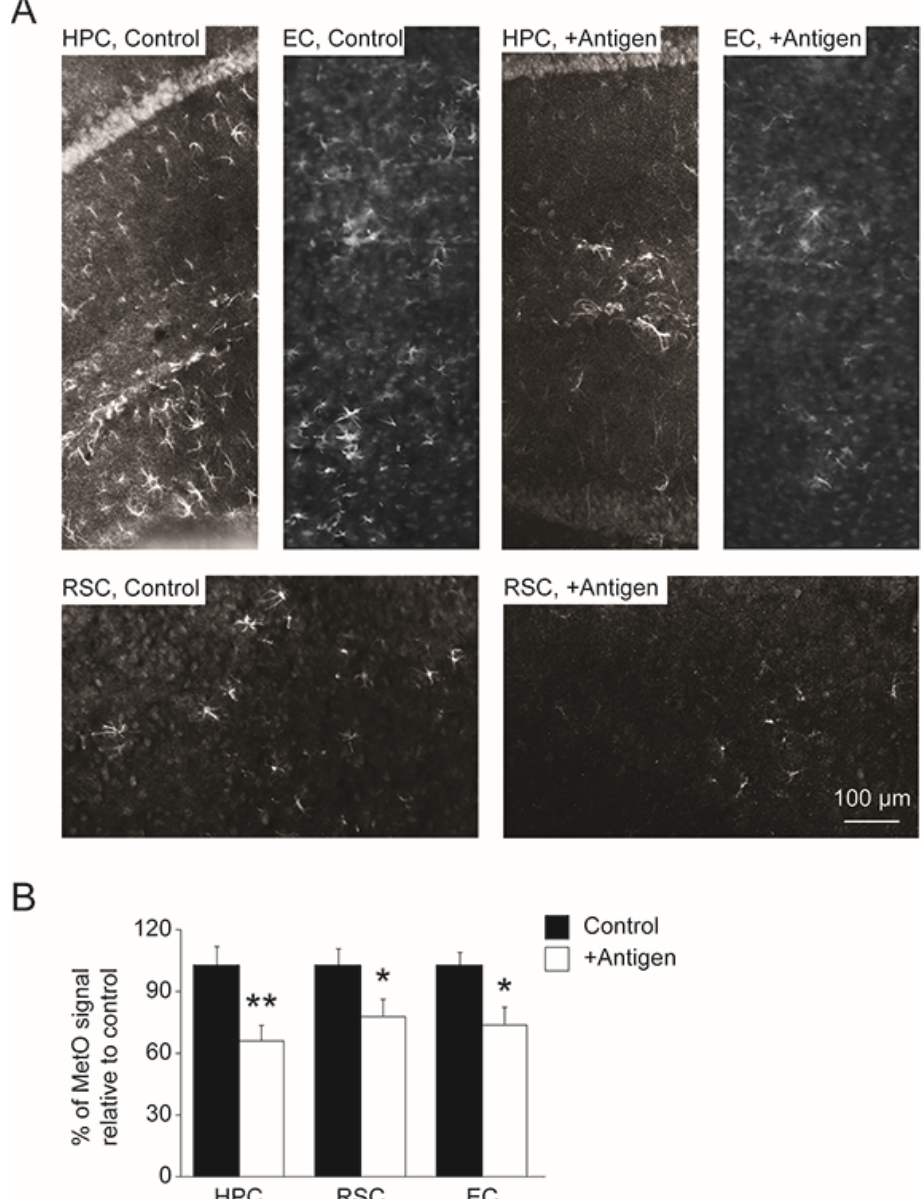
Figure 5. Reduction of MetO-protein levels in brain astrocytes in antigen-injected mice ( A ). Hemisphere brains of post-mortem mice (control and antigen-immunized) were dissected, and immunohistochemistry analyses were performed to detect MetO-proteins according to the procedure described under the Section 2. The data shows a decline in the levels of MetO-proteins in the three brain regions (HPC, hippocampus; RSC, retrosplenial cortex, and EC, entorhinal cortex) of the antigen-immunized compared with control mice. ( B ). Quantification of the data presented in Panel A using NIH-Image J program. Black and white bars represent control and antigen-injected mice, respectively. Standard deviation is shown for each averaged bar. Data were acquired for five mice per tested group of mice. Statistical analyses were performed using two-tailed student t -test with the following p values: *, p < 0.05, and **, p < 0.01.